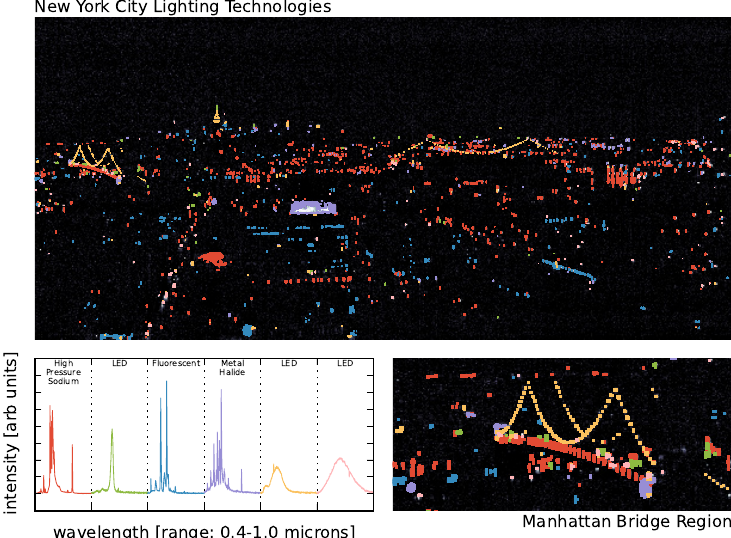
Figure 16. A projection of the cluster tags for several cluster centers on the integrated image of Figure 2 ( top ). The associated spectra (with corresponding colors) are shown in the lower left . A zoom-in of the Manhattan Bridge region is shown in the lower right demonstrating that detailed lighting technology use can be identified with our